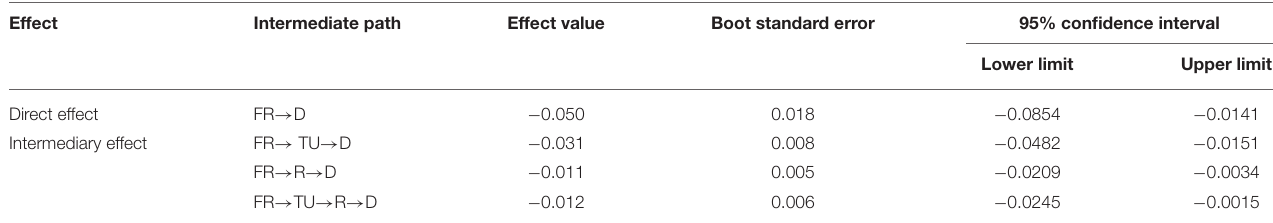
TABLE 3 | Results of specific mediation effect based on